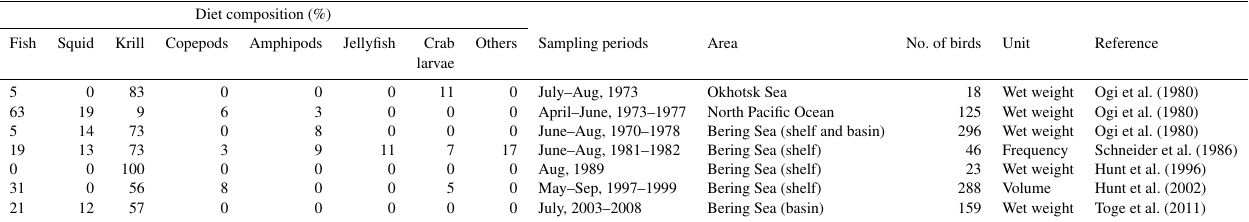
Table 7. Diet composition of short-tailed shearwaters ( Ardenna tenuirostris ) during the non-breeding period. Diet composition (%) Fish Squid Krill Copepods Amphipods